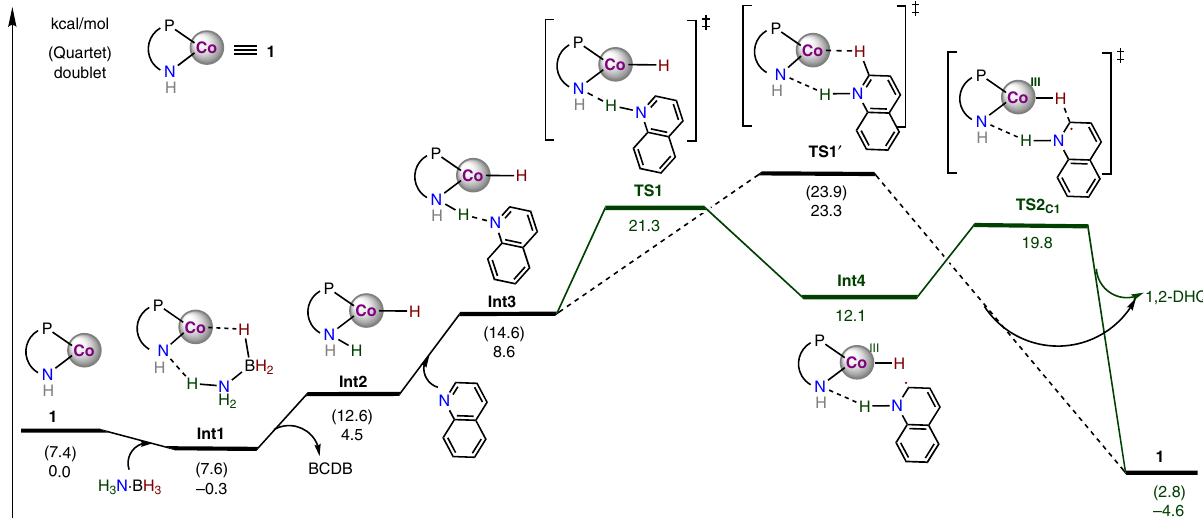
Fig. 7 Gibbs energy diagram. For computational details, see Supplementary